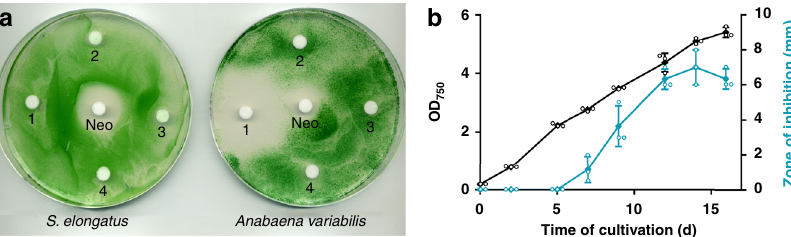
Fig. 1 Extracts of supernatant of Synechococcus elongatus inhibits growth of Anabaena variabilis . a Agar-diffusion plate assay with the effect of organic extracts (1, methanol; 2, chloroform; 3, acetone, and 4, ethyl acetate) of lyophilized supernatant of stationary-phase S. elongatus cultures on the growth of the producer strain and A. variabilis . Neomycin (Neo, 20 µ g) served as positive control. b Optical density of producer strain S. elongatus (black) and zone of A. variabilis growth inhibition (diameter) of methanol extracts of S. elongatus supernatant on agar diffusion plates (turquoise). Values represent the mean values of three biological replicates; standard deviations are indicated. Dots indicate data distribution. Source data are provided as a Source Data fi le